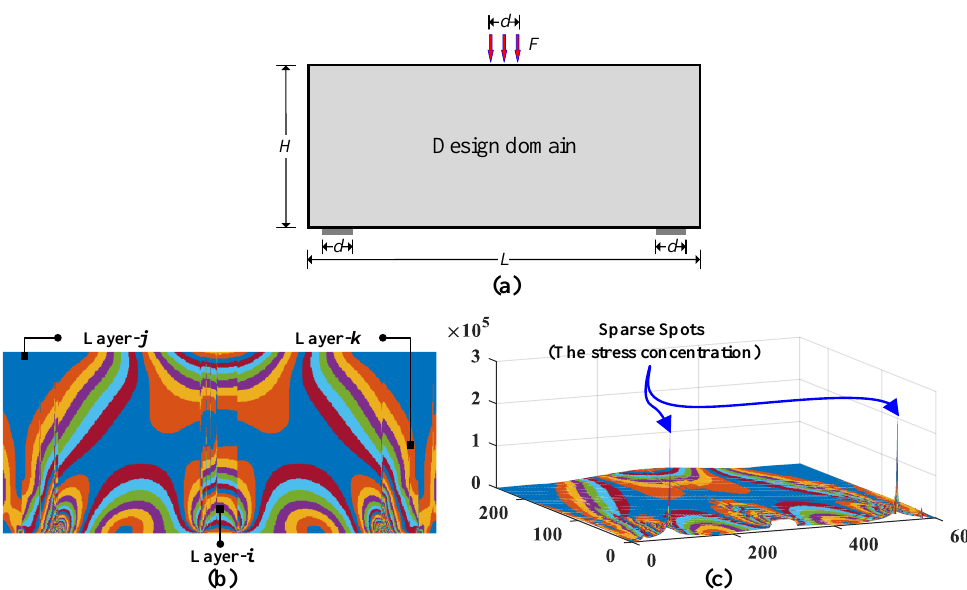
Figure 1. A hierarchical mechanical simulation strain contours with different layers. ( a ) is the design domain and boundary conditions; ( b ) is the strain contour for ( a ) by ANSYS; ( c ) is the three-dimensional display of ( a